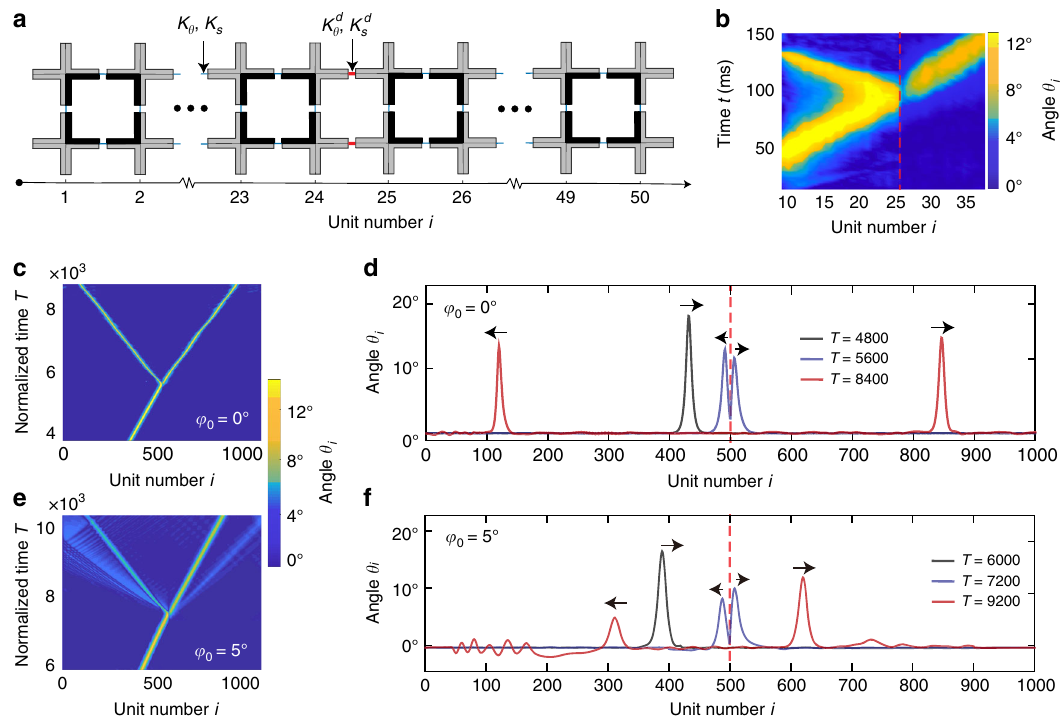
Fig. 3 Soliton splitter. a Schematics of our soliton splitter. A pair of stiffer hinges (with stiffness K d s and K d θ ) is introduced to connect the 24th and the 25th pairs of crosses. b Rotation of the pairs of crosses during the propagation of the pulse, as recorded with our high-speed camera. The location of the stiff pair of hinges is indicated by the dashed red line. c , d Simulations corresponding to the experiments shown in b . The numerical analysis are conducted on a 2 × 1000 chain with symmetric crosses characterized by φ 0 = 0° and a pair of stiffer hinges placed between the 500th and the 501st units. e , f Numerical results for a 2 × 1000 chain with asymmetric crosses characterized by φ 0 = 5° and a pair of stiffer hinges placed between the 500th and the 501st